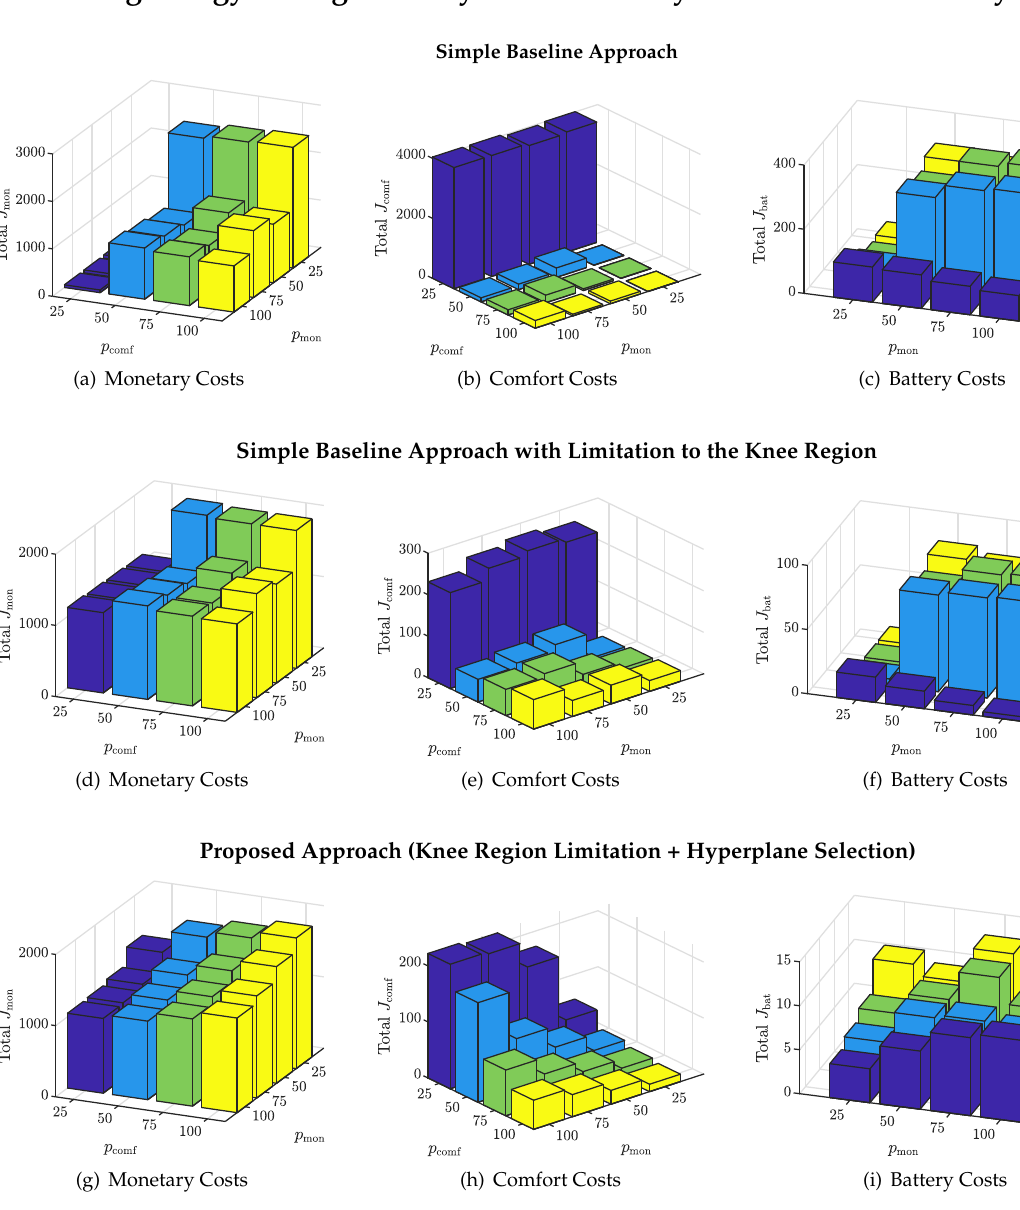
Figure 10. Monetary, comfort and battery degradation costs for the 30 days of 3D simulations with different preferences p mon and p comf and p bat = 50 for ( a – c ) the simple baseline approach and ( d – f ) the simple baseline approach but with limitation to the knee region and ( g – i ) the proposed preference-based decision making approach, with r lim = 0.85 for the latter two cases. Note the different camera angles for better readability and especially the inverted axis for p comf in ( c , f , i ). Subtracted minimum costs for each objective have been determined by single-objective